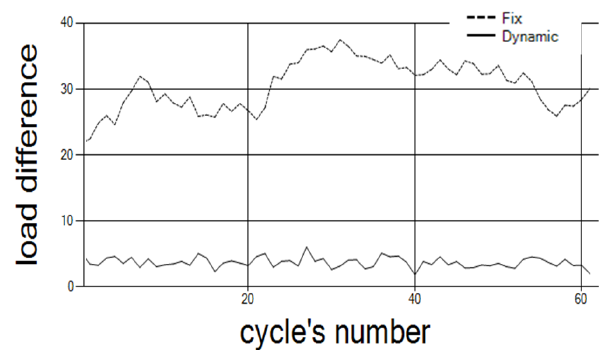
Figure 12. Comparison results of dynamic clusters vs. fixed